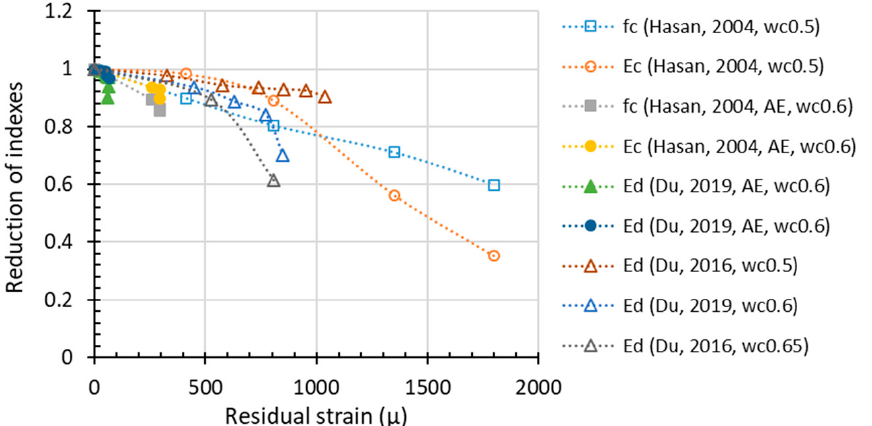
Figure 11. The reduction in mechanical properties in terms of residual strain.